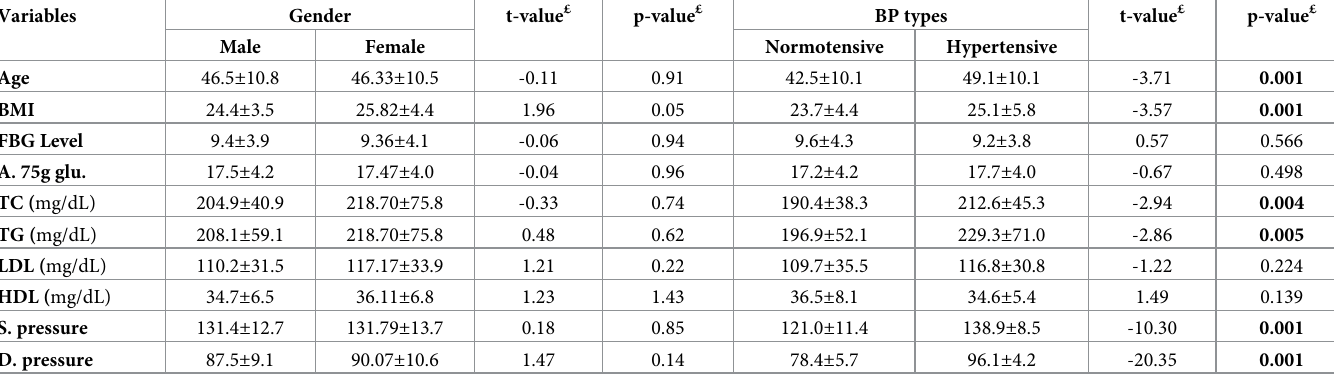
Table 4. Mean ± SD and significance level of different variables based on blood pressure and gender of the respondents.